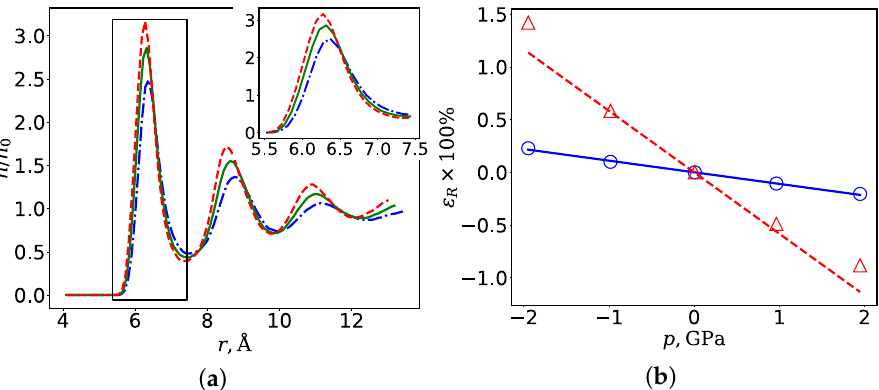
Figure 2. Deformation of an aluminum melt with a spherical inhomogeneity (C 60 ) under uniform compression: ( a ) radial aluminum density distribution at an applied pressure p = − 2 GPa (dashed- dotted curve), p = 0 GPa (solid curve), and p = 2 GPa (dashed curve); and ( b ) deformation of the spherical interface (the solid line and the circles, the interface coincides with the C 60 fullerene surface; the dashed line and the triangles, along the aluminum boundary of radius R 1 , n ( R 1 ) / n 0 = 0.5). The lines show the dependences obtained by approximating the MD data indicated by symbols. The inset shows the first distribution